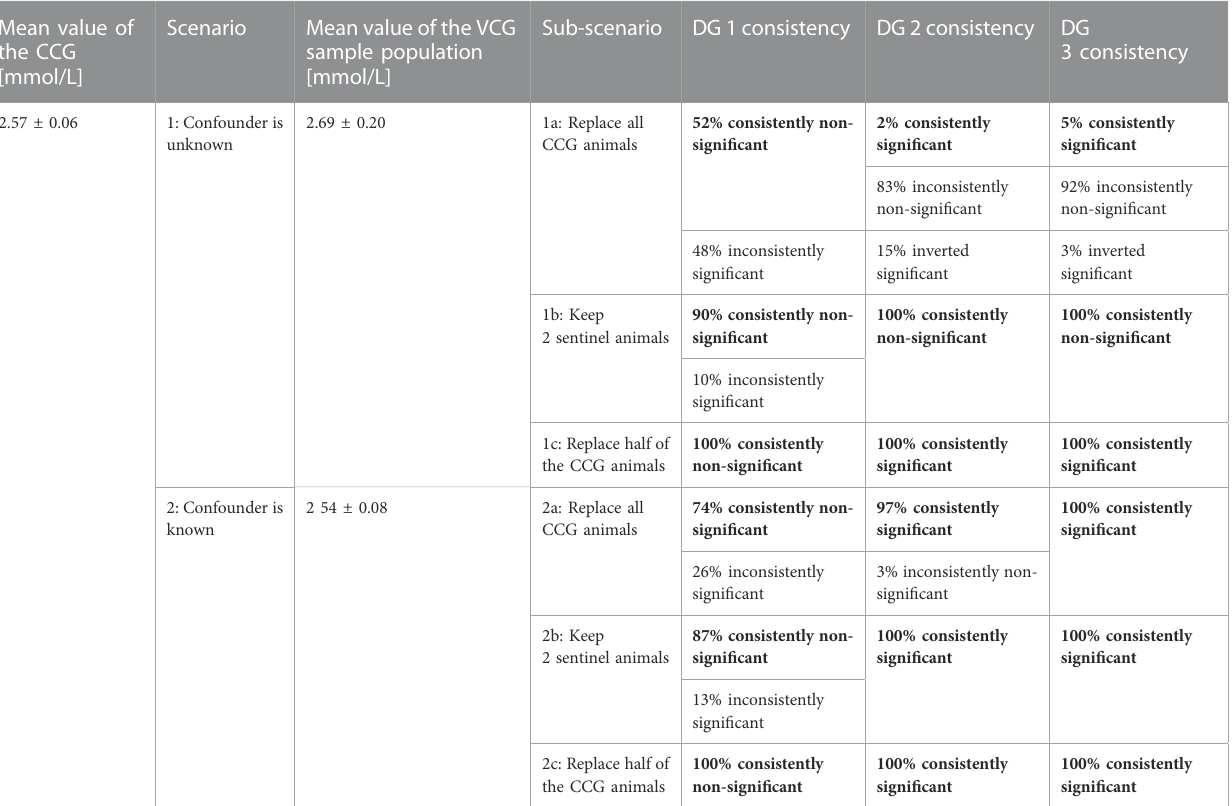
TABLE 2 Resampling results of the legacy study on the parameter calcium after replacing the concurrent control group with virtual control groups (VCG) sampled from the respective subgroups. The sampling was performed 500 times and the percentage of consistent statistical results are given for each sex and each dose group